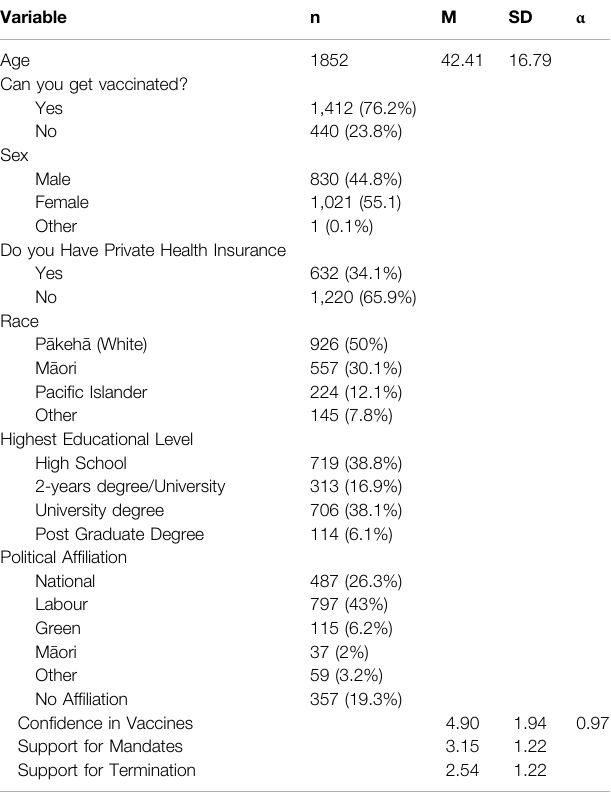
TABLE 1 | Demographic Information, Mean, Standard Deviation, Reliability Coef fi cient.